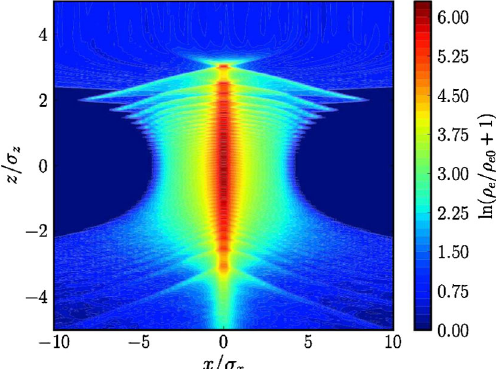
FIG. 5. Stopping power as a function of the electron density. The analytic results obtained from Eq. (20) for (cid:6) z ¼ 0 : 25 m is represented by the solid curve. The symbols represent the results ¼ en e 0 e , obtained from the simulations. The vertical, dotted line corre- sponds to (cid:7) e (cid:6) z ¼ 1 . The dashed blue curve corresponds to Eq. (20) for (cid:6) z ! (cid:6) z = 2 .